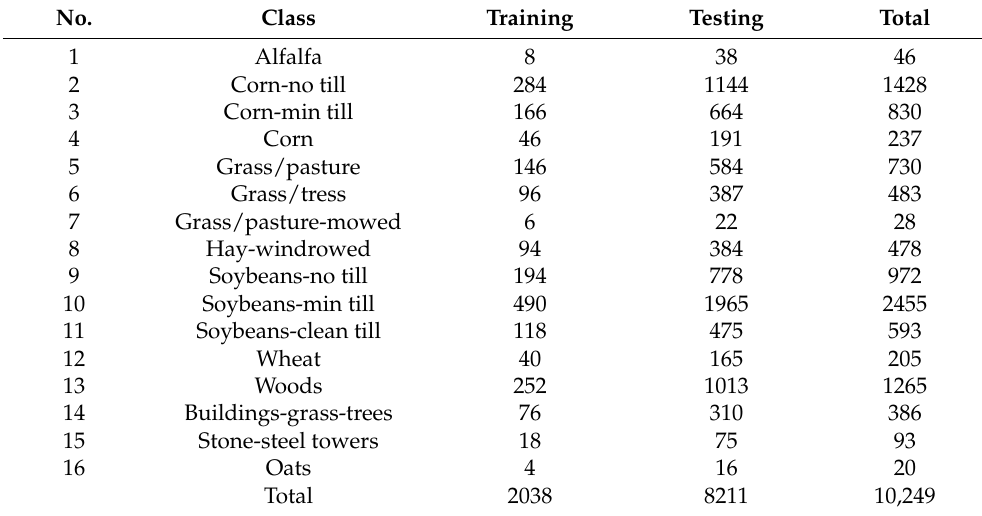
Table 3. Training and testing samples for the IN Dataset.